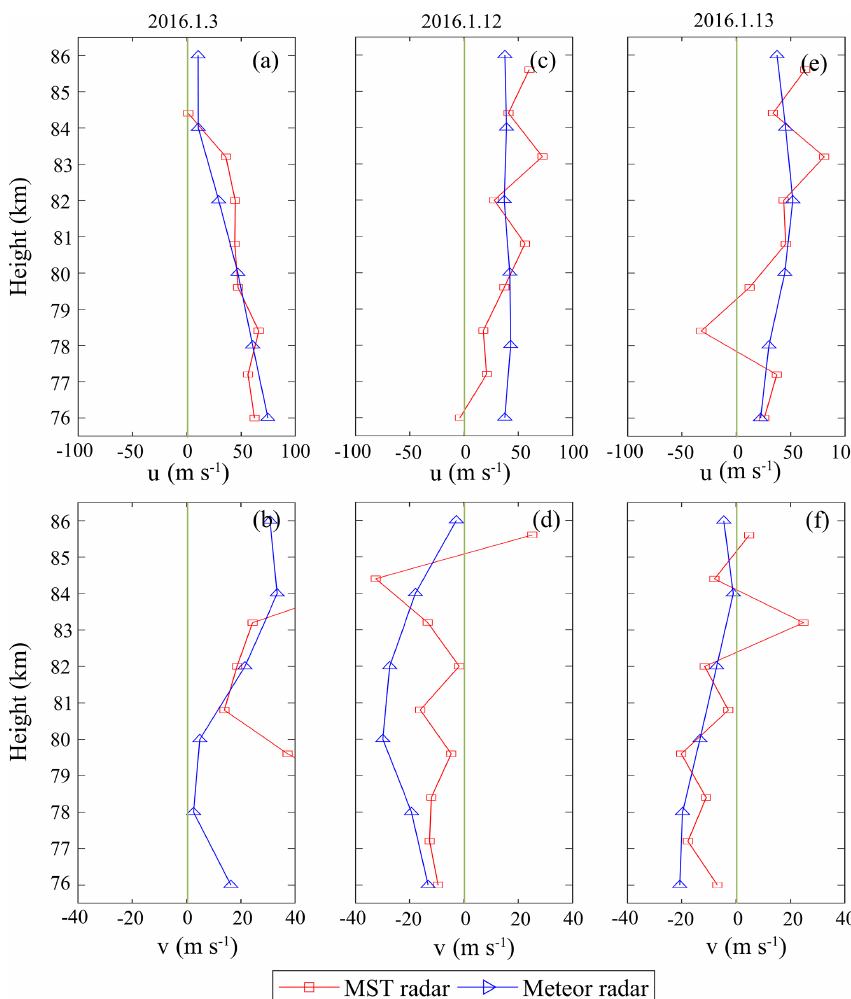
Figure 11. The daily mean zonal ( u ) and meridional ( v ) winds at heights of 76 to 86km observed by the Wuhan MST radar (red lines) and the Wuhan meteor radar (blue lines) on 3 January 2016 (a, b) , 12 January 2016 (c, d) , and 13 January 2016 (e, f)